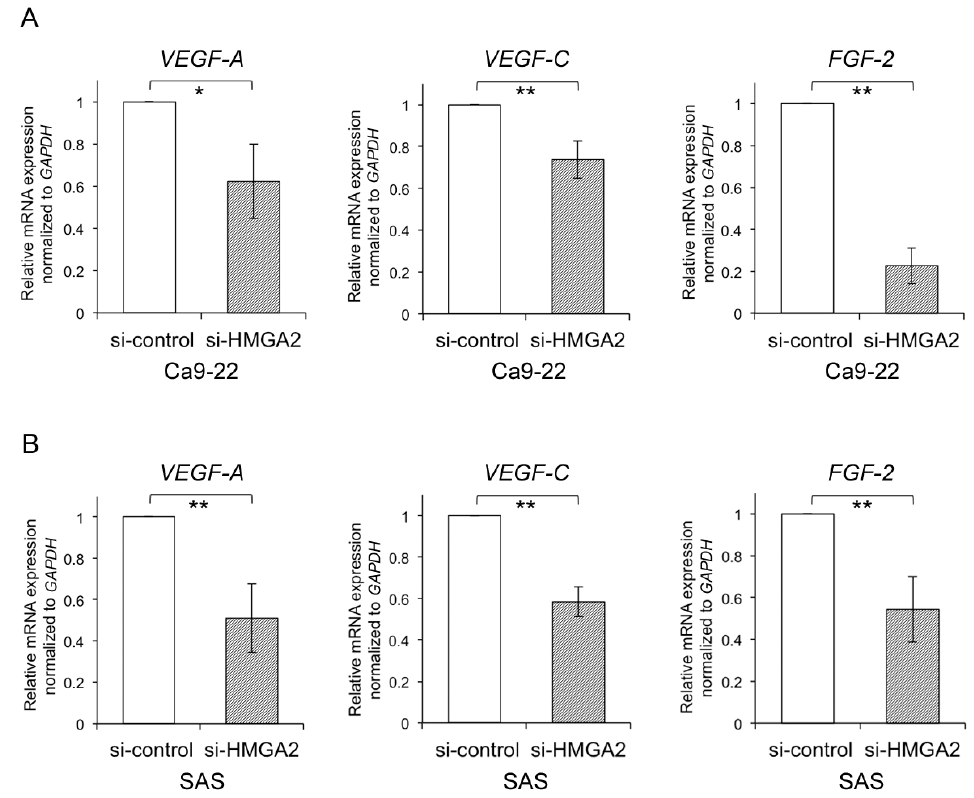
Figure 3. HMGA2 regulates the expression of angiogenesis genes in oral squamous cell carcinoma (OSCC) cell lines. ( A , B ) The mRNA expression levels of VEGF-A , VEGF-C , and FGF-2 were measured using qRT-PCR in Ca9-22 cells ( A ) and SAS cells ( B ) transfected with si-HMGA2. The values are expressed as the means ± s.d. of triplicate samples. Statistical analysis was performed using the Student’s t -test. * p < 0.05, ** p <